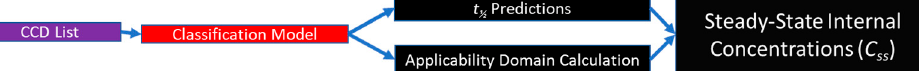
Figure 1. Scientific workflow including ( A ) Training Data Assembly, ( B ) Predictor Dataset Assembly, ( C ) Dataset Processing and Preparation, ( D ) Random Forest Model Construction, and ( E ) Application of the Models to the CCD PFAS list. Green boxes denote data sources, purple boxes denote assembled datasets, red boxes denote models, blue boxes data denote processing steps, black boxes denote model outputs, and arrows indicate flow between steps.